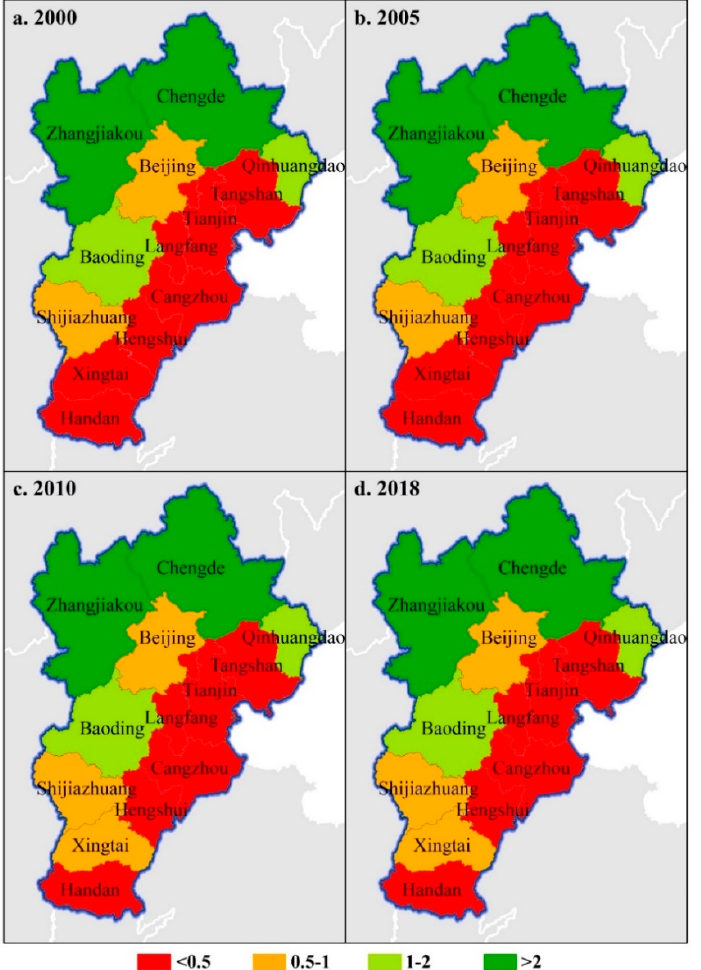
Figure 9. Spatiotemporal evolution of the ecological support coefficient in Beijing–Tianjin–Hebei from 2000 to 2018.